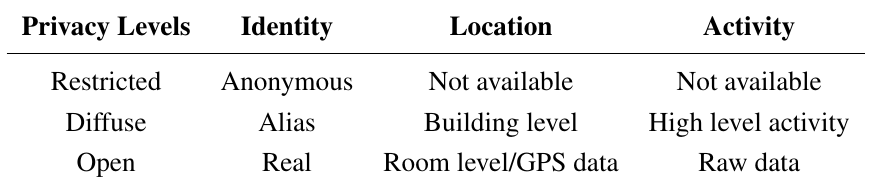
Table 1. Context variables are filtered using different granularity depending on the privacy